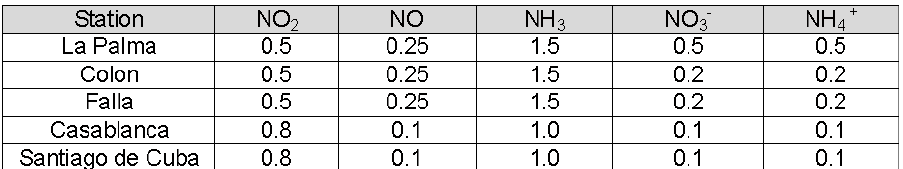
Values Selected of the Deposition Velocity in cm s – 1 for the Gases and Aerosols in Dependency of Land Use and Climatic